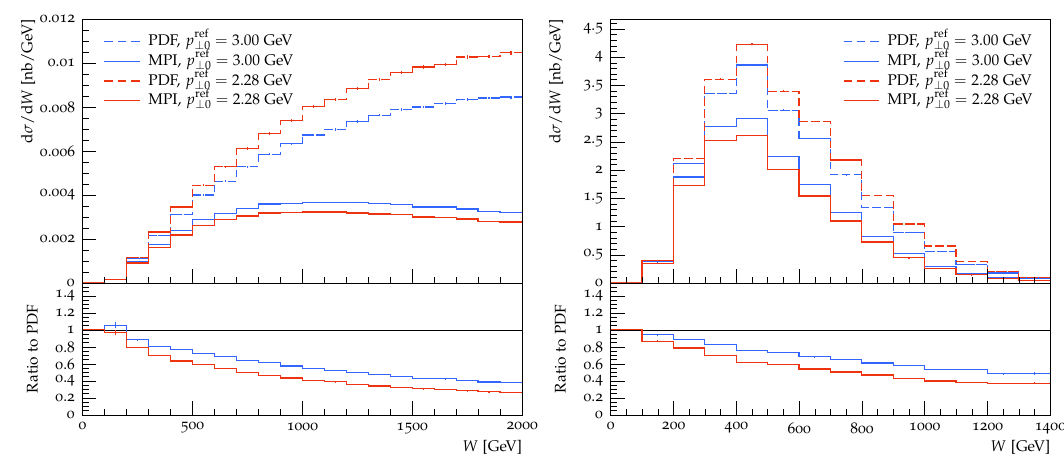
Figure 4: The differential cross sections in terms of W corresponding to UPCs in proton-proton (left) and proton-lead (right) collisions at the LHC with (solid) and without (dashed) the MPI rejection using the default (red) and HERA-tuned (blue) MPI